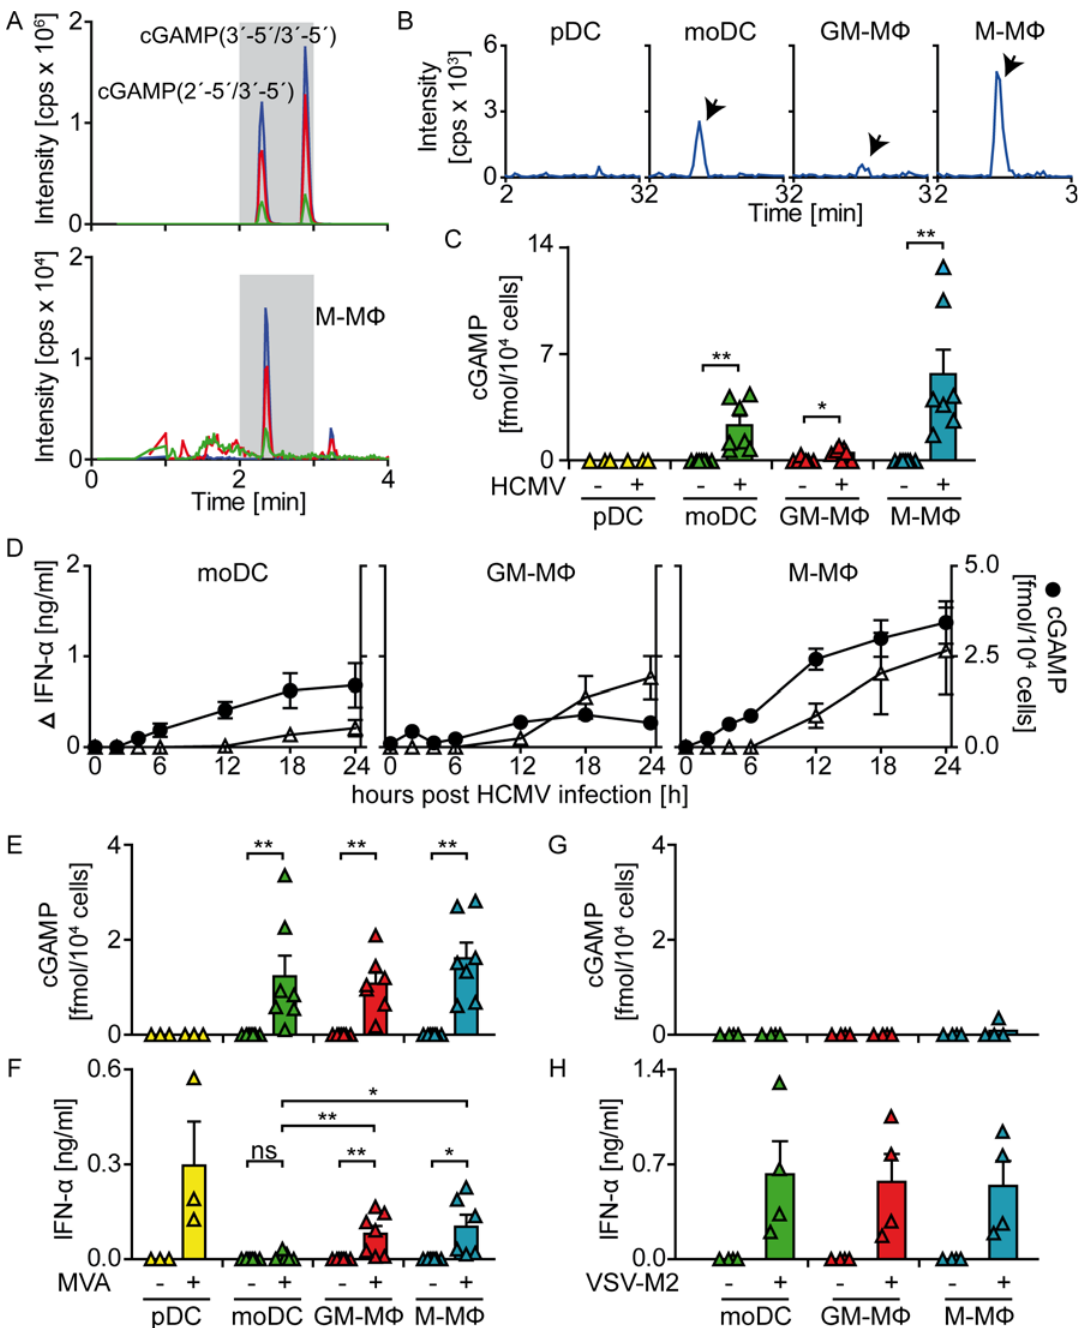
Fig 3. HCMV infection induces cGAMP formation in monocyte-derived DC and M Φ , but not in pDC. cGAMP synthesis was analyzed and quantified using a HPLC-MS/MS method. Chromatograms (blue line: quantifier, green/red lines: identifiers) of (A) synthetic cGAS-derived cGAMP (2´-5´/3´-5´) and bacterial cGAMP (3´-5´/3´-5´) (upper panel) or lysed, HCMV stimulated M-CSF M Φ (lower panel) as well as (B) lysates of 24 h HCMV infected pDC, moDC, GM-CSF M Φ , and M-CSF M Φ (enlarged visualization of grey area shown in (A)). (C) Quantification of the detected cGAMP shown in (B). (D) cGAMP (filled circles) synthesis and IFN- α contents in cell-free supernatants (open triangles) were monitored in unstimulated (0 h) moDC, GM-CSF M Φ , and M-CSF M Φ or at indicated time points after HCMV treatment. pDC, moDC, GM-CSF M Φ , and M-CSF M Φ were infected with MVA at MOI 1 and 24 hpi (E) cGAMP synthesis as well as (F) IFN- α contents of cell-free supernatants were quantified. moDC, GM-CSF M Φ , and M-CSF M Φ were infected with VSV-M2 at MOI 1 and 24 hpi (G) cGAMP synthesis as well as (H) IFN- α contents of cell-free supernatants were quantified. Mean ± SEM of 4 – 7 (C), 4 (D), 3 – 7 (E, F), or 4 (G, H) different donors. ns = not significant, * : p (cid:1) 0.032, ** : p (cid:1) 0.0078 one-tailed Wilcoxon signed rank test.